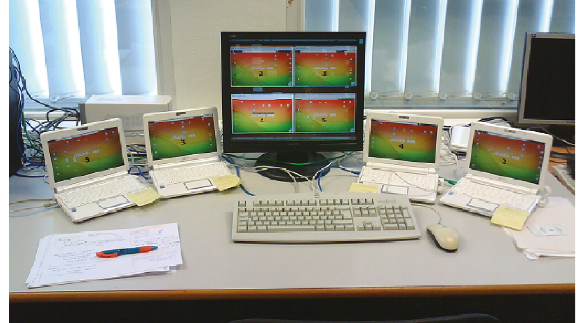
Figure 7: Snapshot of the testbed used for performance evaluation